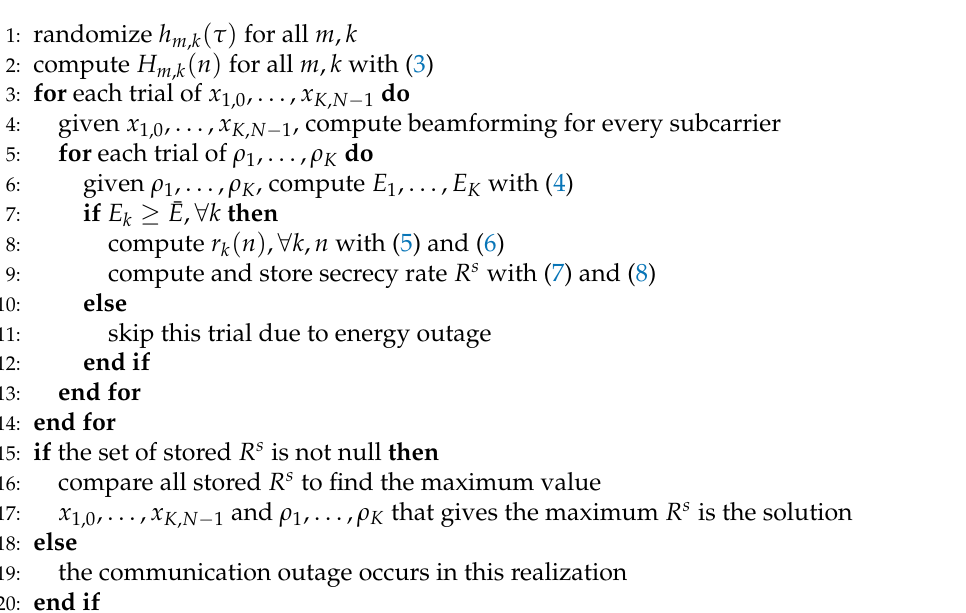
Algorithm 1 Maximizing the lowest total secrecy rate in a